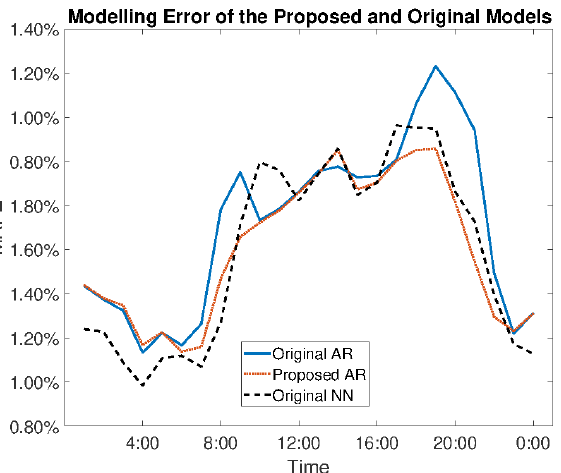
Figure 5. Forecasting error by time of day of the original and proposed autoregressive (AR) models and the neural network (NN)